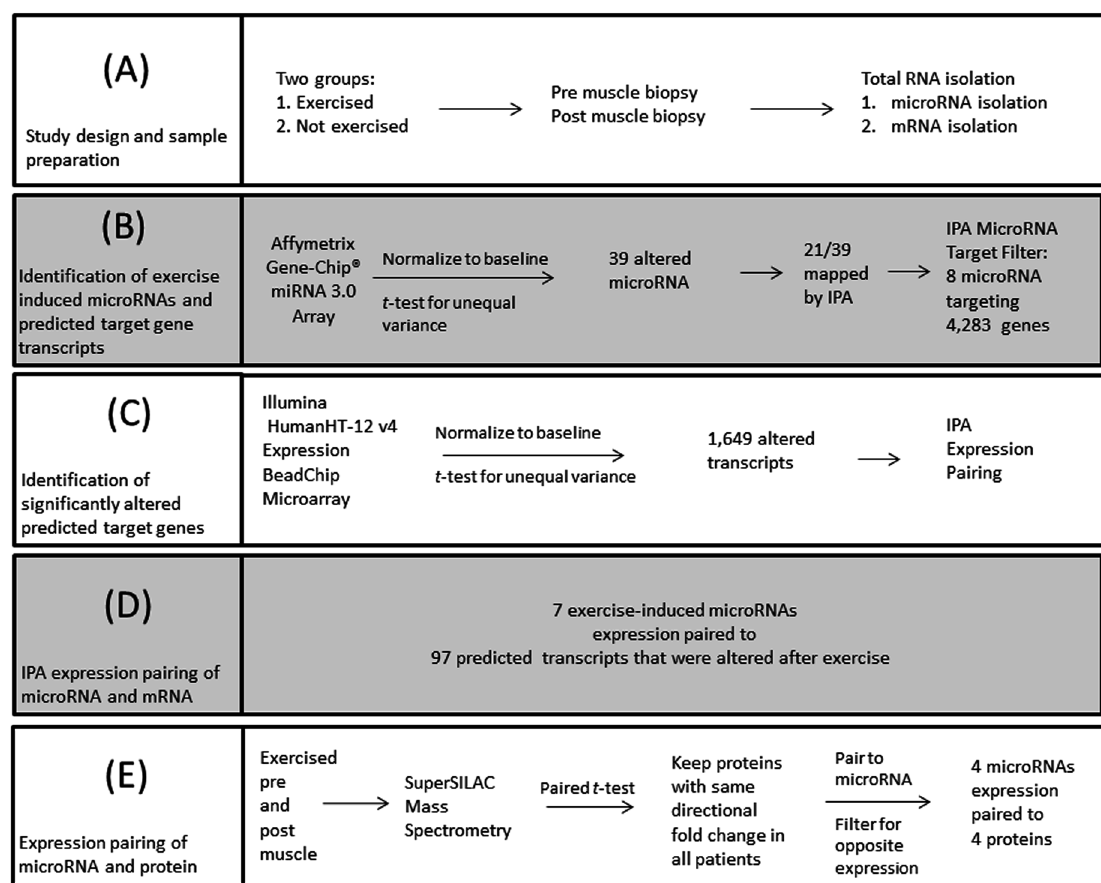
Fig 2. Overviewof the data analysis of exercisedand non-exercised myositis patients. The abovework plan was used to the identify exercised-inducedmicroRNA interactions in myositis patients. (A) Total RNA was extracted from baseline(pre) and exercised(post) muscle biopsiesfrom the exercise group and the control group. (B) After pre values were subtracted from post values as an internalcontrol measure, a total of 39 microRNAs were identified.Ingenutiy Pathway Analysis (IPA) MicroRNA Target Filter identifiedthat 8 of these microRNAs had predicted transcript targets. (C) A gene expression microarray was run to identify if any of these transcript targets were altered in the patients after exercise. (D) Expression pairingbetweenthe microRNA and mRNA data sets was performed using IPA to determine biologicalrelevance. (E) Protein was extracted from pre and post exercisedmuscle for SuperSILAC mass spectrometry. Expression pairingwas again performed with microRNAand protein data sets since microRNAs are known to inhibit